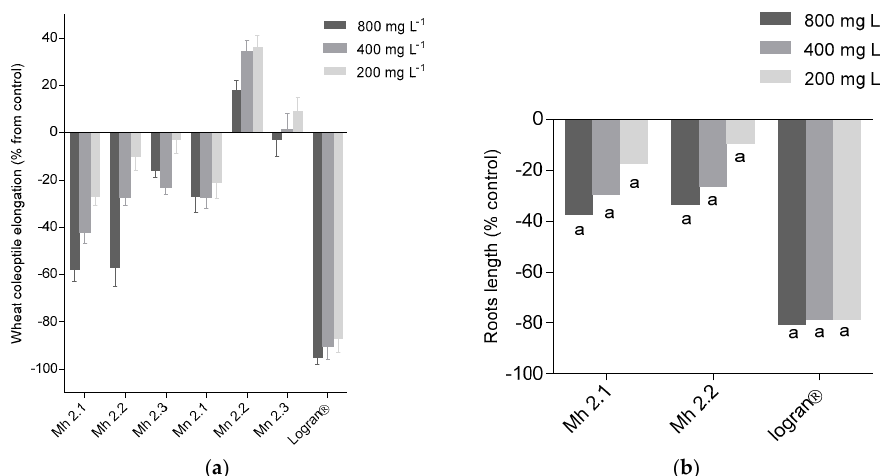
Figure 2. ( a ) Effect of extracts of M. nobilis (Mn) and M. herndandoi (Mh) on etiolated wheat coleoptile elongation. Values are expressed as percentage difference from the negative control. ( b ) Effect of extracts Mh 2.1 and Mh 2.2 from M. herndandoi on root growth of STS: Lycopersicum esculentum W. Values are expressed as percentage difference from the negative control and are not significantly different with P > 0.05 for Welch’s test. a Values significantly different with P < 0.01. b Values significantly different with 0.01 < P < 0.05.